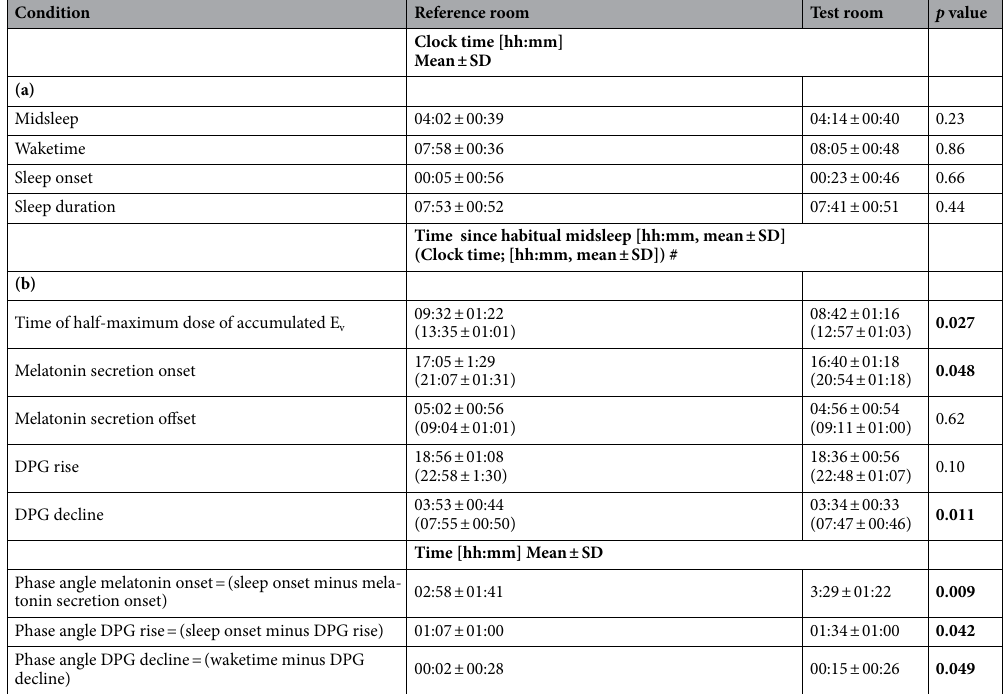
Table 2. (a) Summary of habitual sleep times and (b) melatonin secretion onset and offset times, DPG rise/ decline and phase angles. (a) Habitual midsleep time, waketime, sleep onset time and sleep duration (hh:mm), mean per condition ± SD (derived from activity watches) are shown for both conditions (derived from the 7 nights prior the laboratory week and were used for calculation of melatonin and DPG onset, offset times and phase angles during both room conditions in (b)); (b) time of half-maximum dose of accumulated E v , melatonin onset and offset times, DPG rise and decline times since midsleep (these times are also indicated in clock times, in brackets). Phase angle durations are shown for time ranges between: melatonin onset time and sleep onset time; DPG rise time and sleep onset time; DPG decline time and waketime. Significant p values are shown in bold; # clock times derived from habitual midsleep time for each condition separately; average midsleep time differed by 12 min between the two conditions ( p =